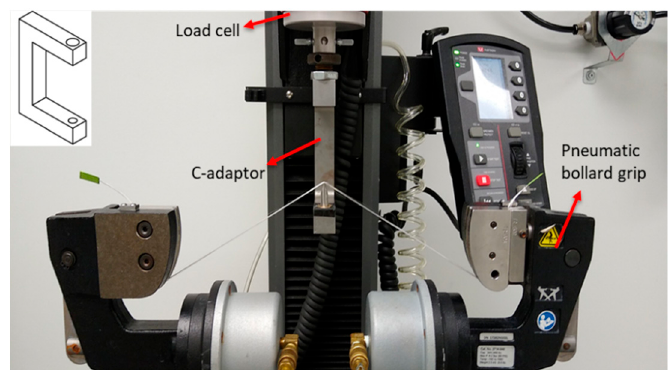
Figure 1. Transverse loading experimental set-up. Fibers 2020 , 8 , x FOR PEER REVIEW